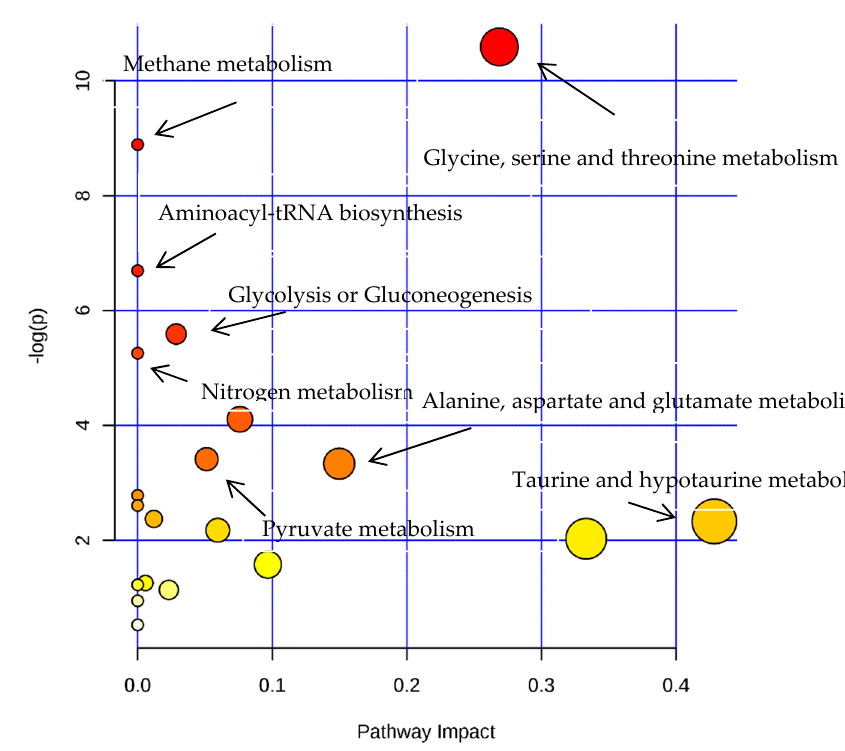
Molecules 2019 , 24 , x FOR PEER REVIEW Figure 9. The pathway analysis of all di ff erential metabolites between LPS and control groups. Figure 9. The pathway analysis of all differential metabolites between LPS and control groups.